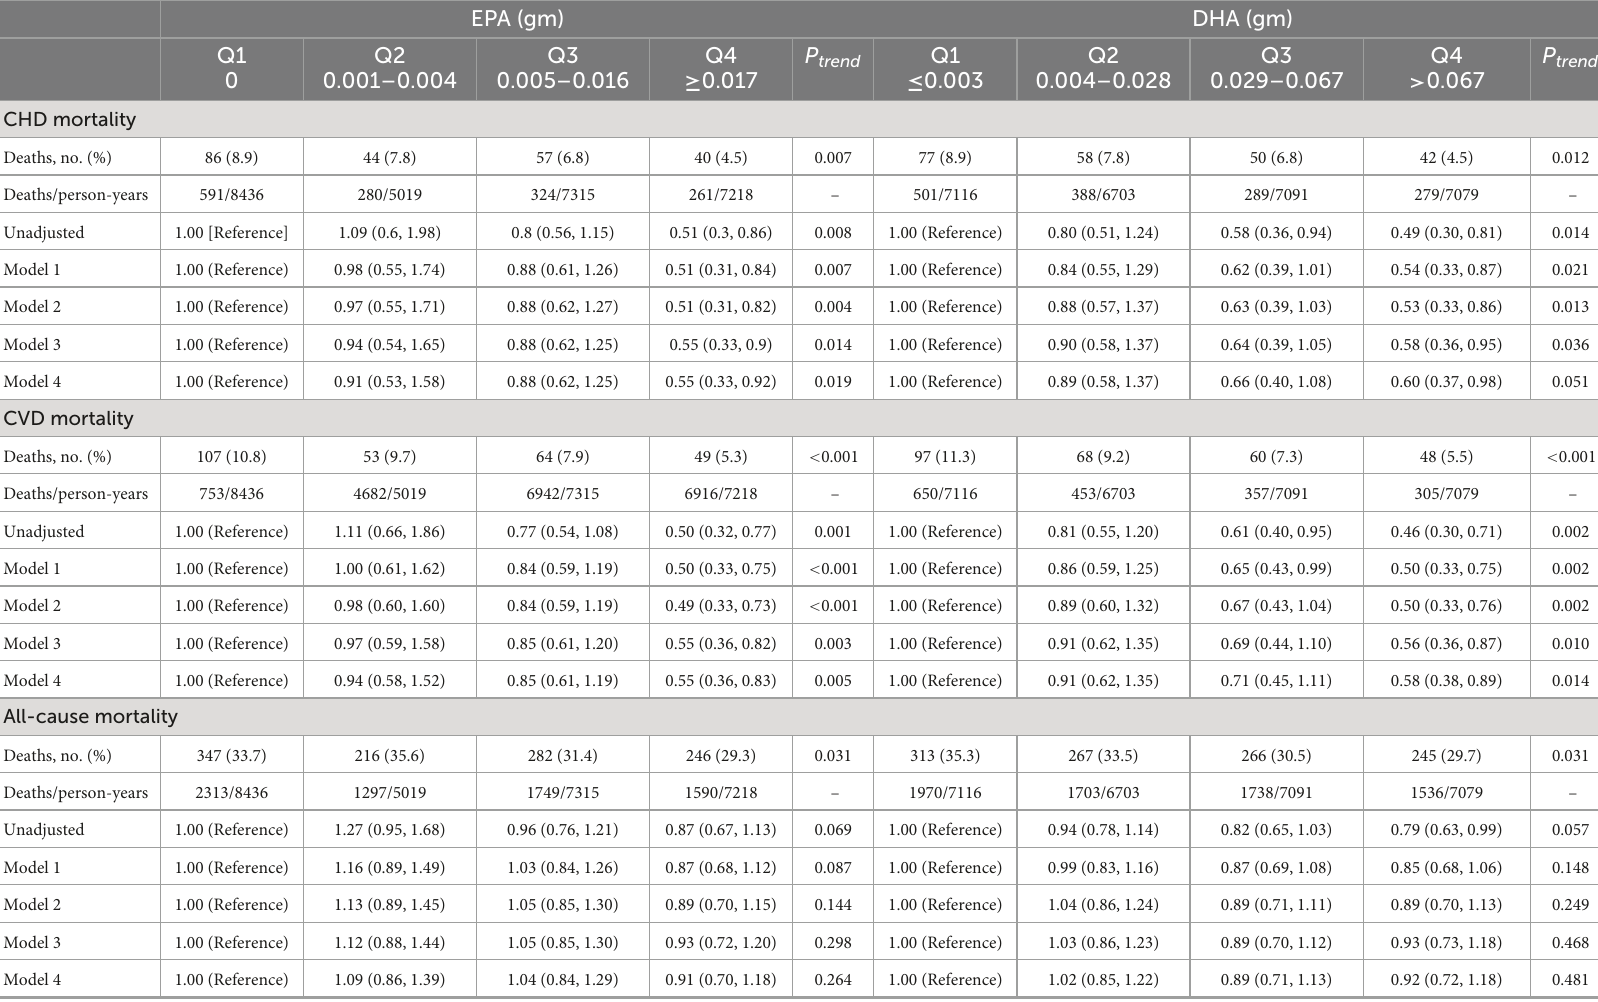
TABLE 2 Associations of the intake of eicosapentaenoic acid (EPA) and docosahexaenoic acid (DHA) with cardiovascular and all-cause mortality in United States adults aged at least 20